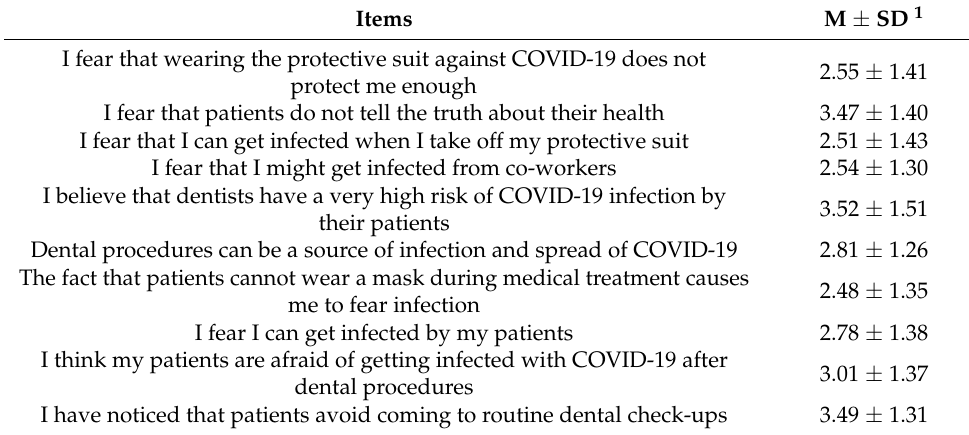
Table 2. Fear of infection—self-rated